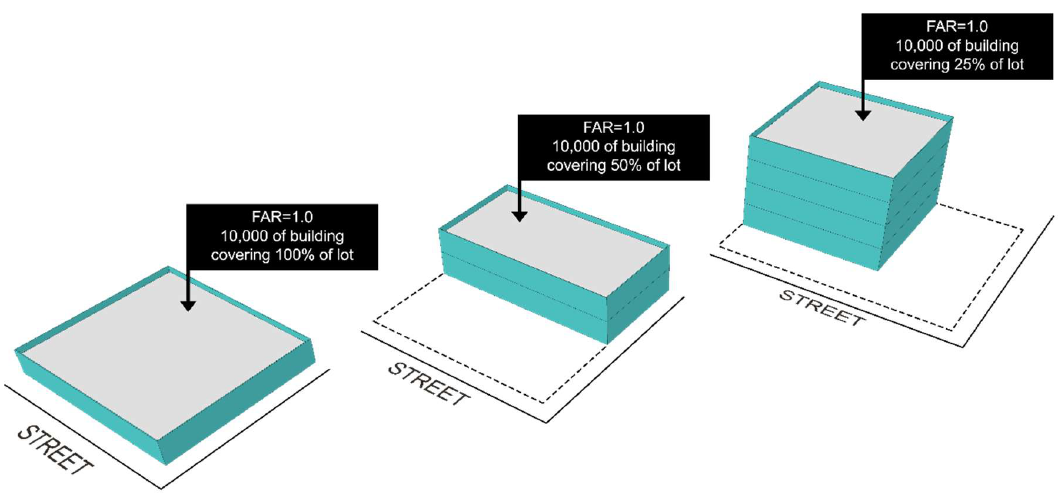
Figure 5. Floor Area Ratio calculations (illustration sourced by authors).